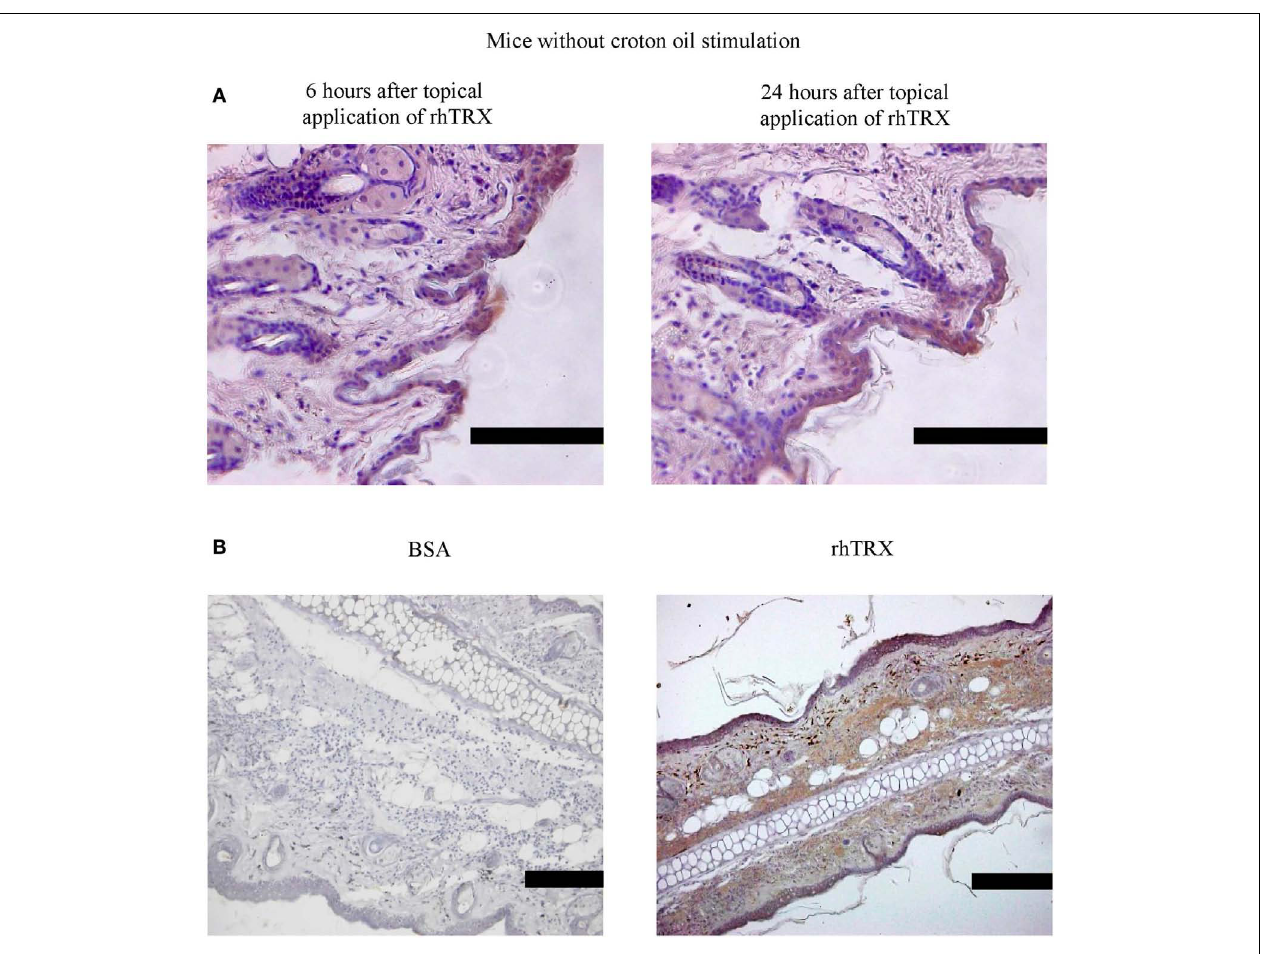
the mice without the croton oil stimulation. Bars, 100 µ m ( n = 5). (B) After croton oil was applied, the rhTRX was distributed in both the epidermis and dermis in irritant dermatitis in the group with the rhTRX pre-treatment at 24h. Bars, 50 µ m ( n =